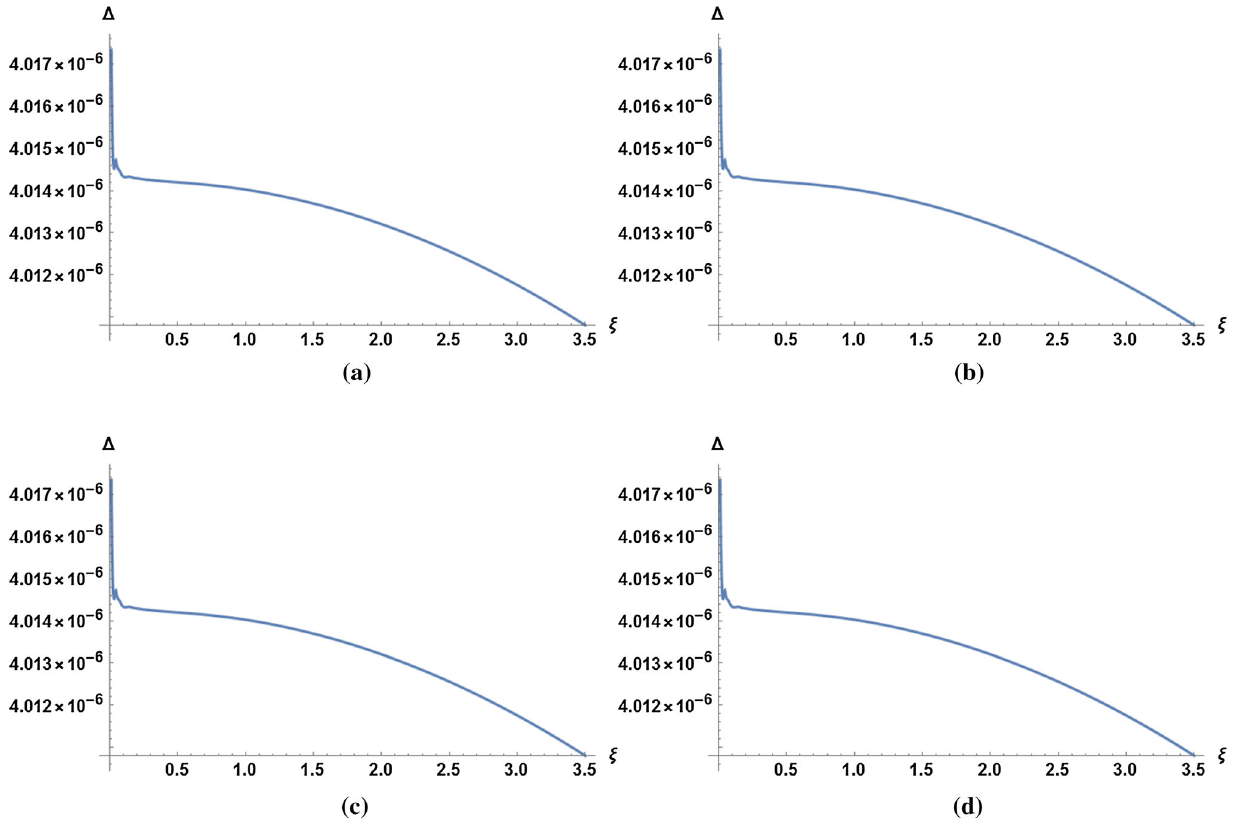
Fig. 3 Graphs between ξ and (cid:12) ; for α 1 = . 5, n = 1 and α = 10 − 10 (curve a ); α = 2 × 10 − 10 (curve b ); α = 4 × 10 − 10 (curve c ) and α = 4 × 10 − 10 (curve d